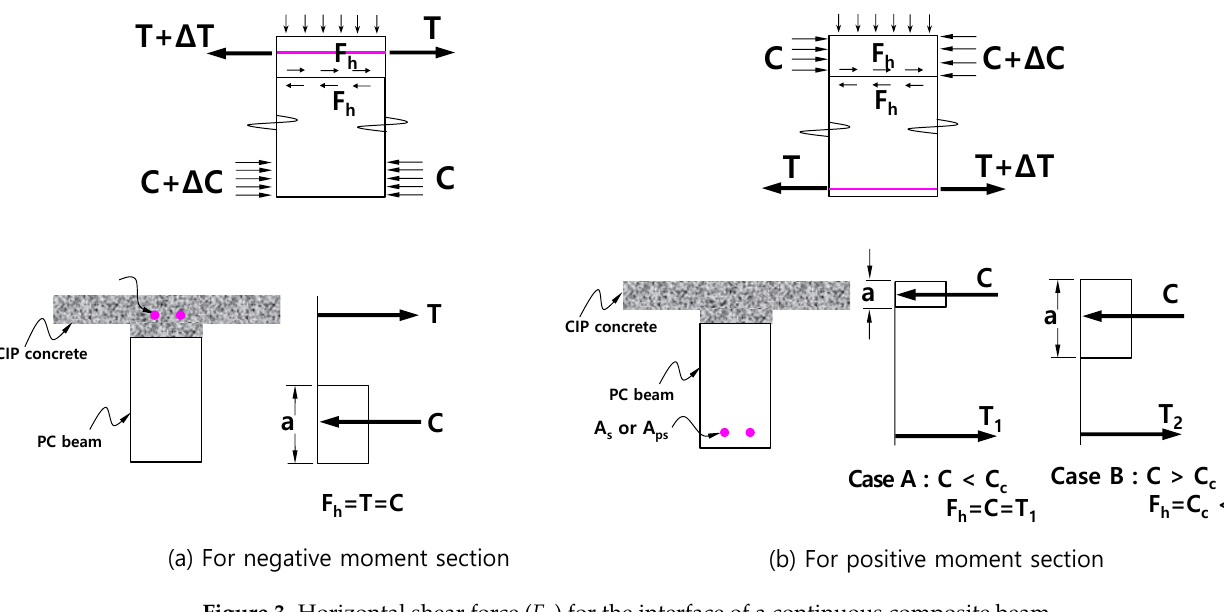
Figure 3. Horizontal shear force ( F h ) for the interface of a continuous composite beam.